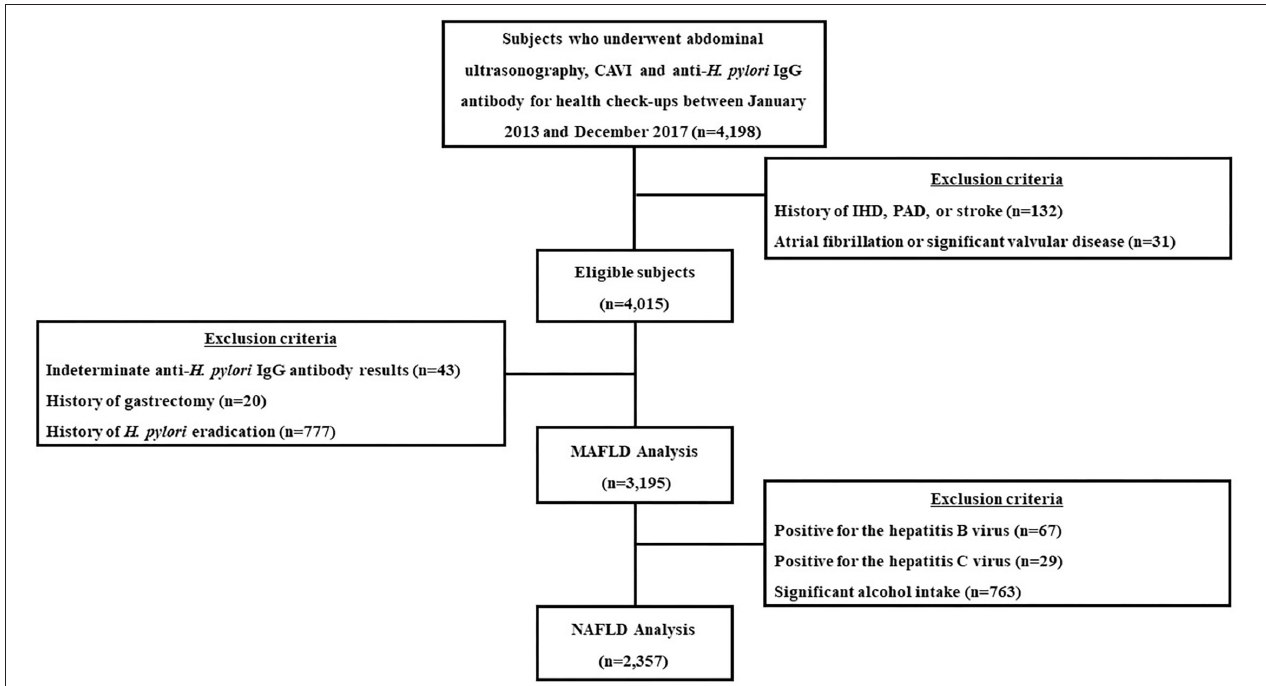
FIGURE 1 | A flow diagram of the study population. CAVI, cardio-ankle vascular index; H. pylori, Helicobacter pylori ; n, number; IHD, ischemic heart disease; PAD, peripheral artery disease; MAFLD, metabolic-dysfunction associated fatty liver disease; NAFLD, nonalcoholic fatty liver